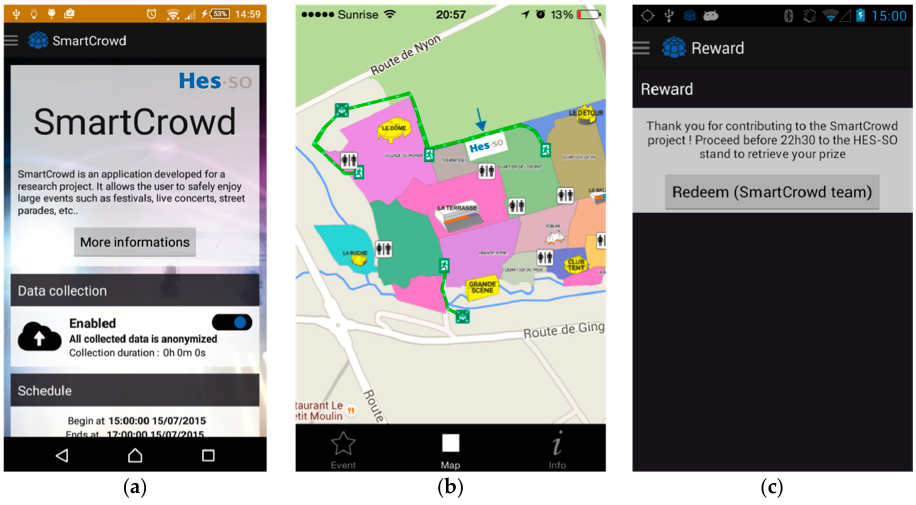
Figure 5. Three screenshots of the SmartCrowd application showing: ( a ) The main screen; ( b ) The map; ( c ) The reward